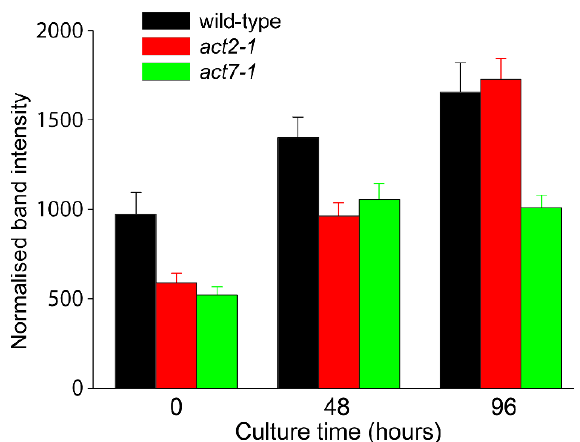
Figure 5. Semi ‐ quantitative immunoblotting of total actin levels across culture of protoplasts derived from wild ‐ type (Col ‐ 0), act2 ‐ 1, and act7 ‐ 1 . Total protein was extracted from cultured protoplasts at the indicated time points and immunoblotting was performed with C4 anti ‐ actin monoclonal antibody. Normalised band intensities were determined by duplicate immunoblots probed with anti ‐ ß ‐ tubulin. Data is mean ± SE, n = 3 experiments.